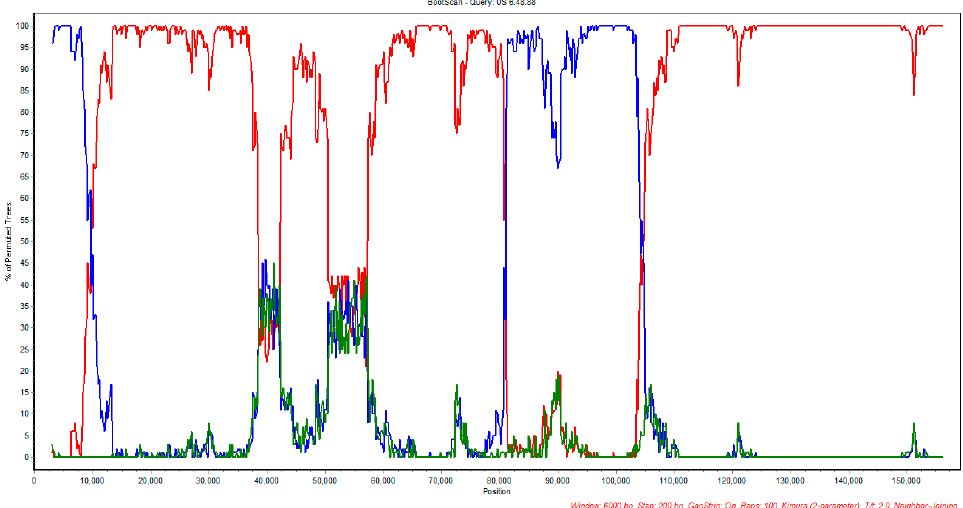
Figure 4. Bootscan analysis plot of CAN / AB-S20 with the suggested parental vaccine strain CAN / AB-S20 (blue) and SA2 (red). US 1874C5 strain was used as control (green).